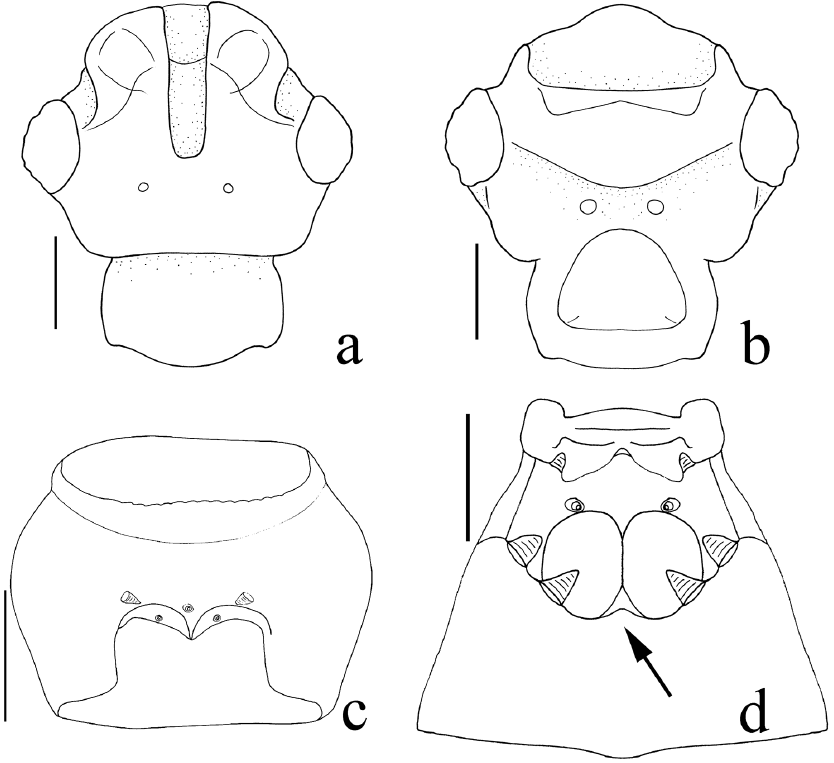
Figure 3. Heads of Nornalup afoveatus sp. n. a dorsal view b ventral view. N. quadratus sp. n. c proster- num, ventral view d meso- and metaventrite, ventral view. Scale bars: 0.1